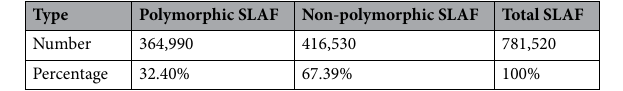
Table 1. SLAF marker mining results.